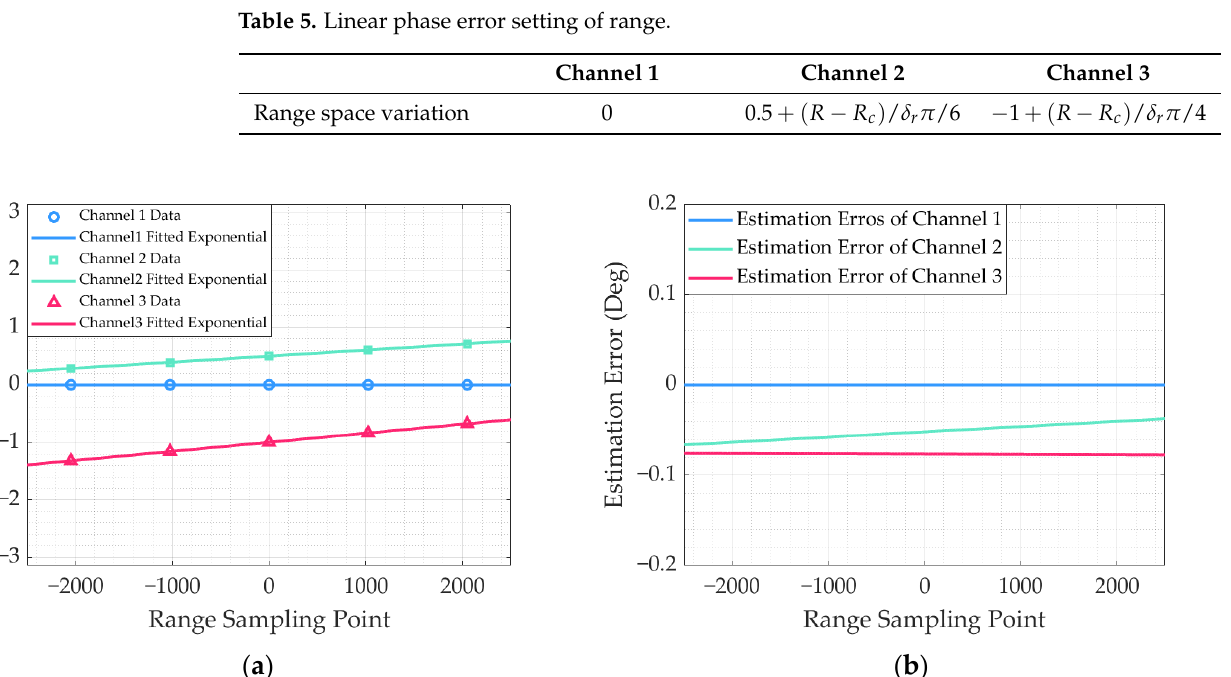
Table 5. Linear phase error setting of range.